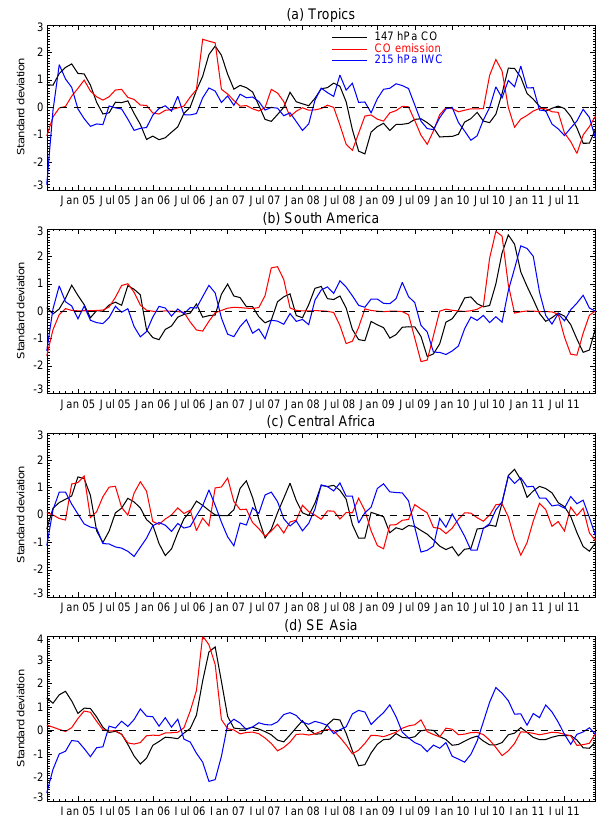
Fig. 2. Time series of monthly anomalies of MLS CO at 147hPa (black), surface CO emission (red) and MLS ice water content (IWC) at 215hPa over (a) the tropics (15 ◦ S–15 ◦ N, 180 ◦ W– 180 ◦ E), (b) South America (15 ◦ S–12 ◦ N, 85–32 ◦ W), (c) central Africa (15 ◦ S–15 ◦ N, 20 ◦ W–50 ◦ E), and (d) SE Asia (10 ◦ S–15 ◦ N, 90–160 ◦ E) for the period of August 2004–December